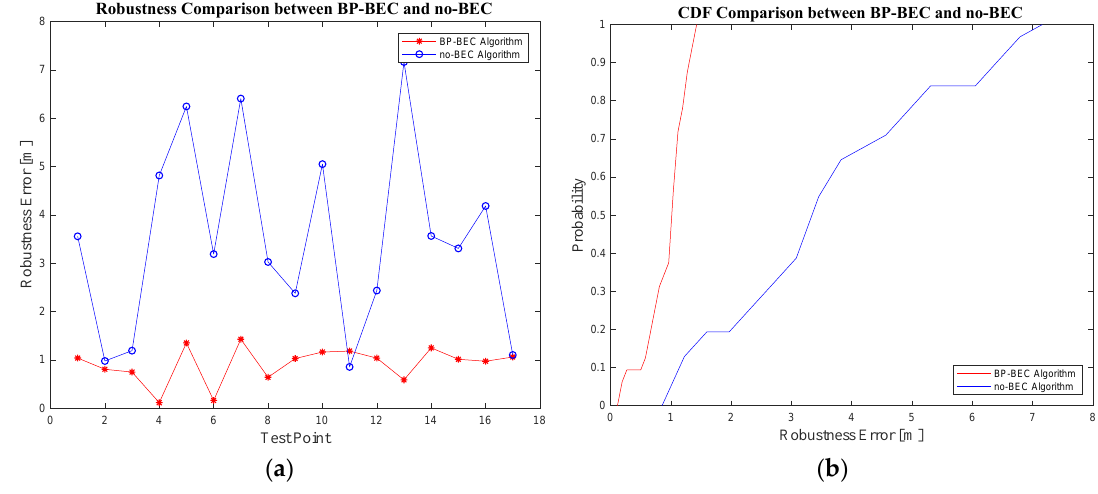
Figure 15. The comparison of positioning robustness between the BP-BEC algorithm and the traditional algorithm: ( a ) positioning robustness error comparison in scatter diagram; ( b ) positioning robustness error comparison in CDF. Table 4. Robustness error comparison between the BP-BEC and the no-BEC algorithms